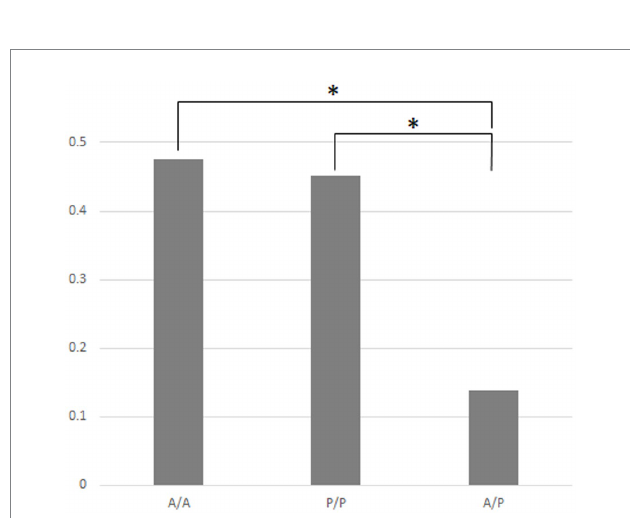
FIGURE 5 Homology of the bacterial composition among eight actively and six poorly proliferating P. bursaria strains, as well as a homology comparison of the microbiome composition between these two types of P. bursaria strains (LEfSe analysis). The higher the homology, the closer the numerical value to 1. Left and center bars show mean values compared between the actively proliferating strains (A/A) and poorly proliferating strains (P/P), respectively. The right bar shows the mean of the values compared between these two strains (A/P). Asterisks indicate that differences are statistically significant from each